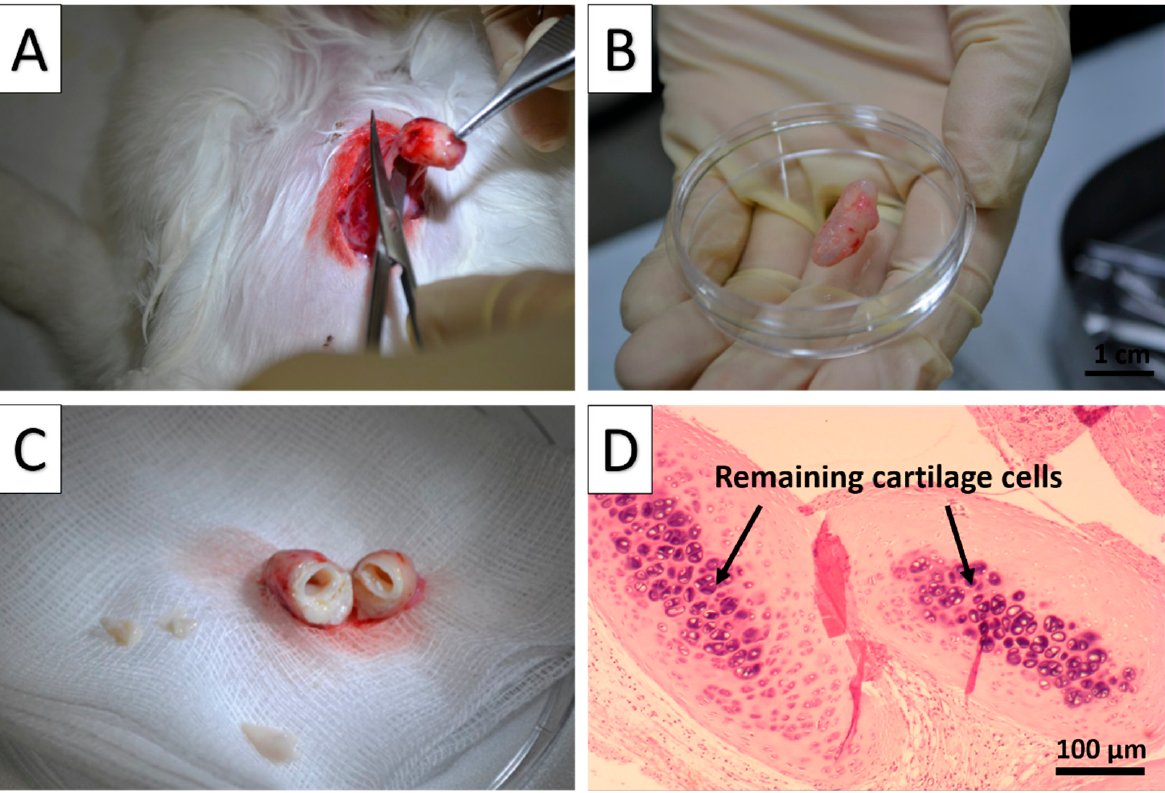
Figure 4. Evaluation of the decellularized tracheal segments after heterotopic muscle implantation. ( A ): Harvest from chest muscle; ( B ): Gross appearance of the harvested trachea 2 months postimplantation; ( C ): Lumen of implanted scaffold appear to be grossly intact; ( D ): H&E staining of harvested trachea 2 months after implantation showed partial cartilage cell loss at the outer layer of the cartilage, while the core remaining cartilage cells were clearly visible (black